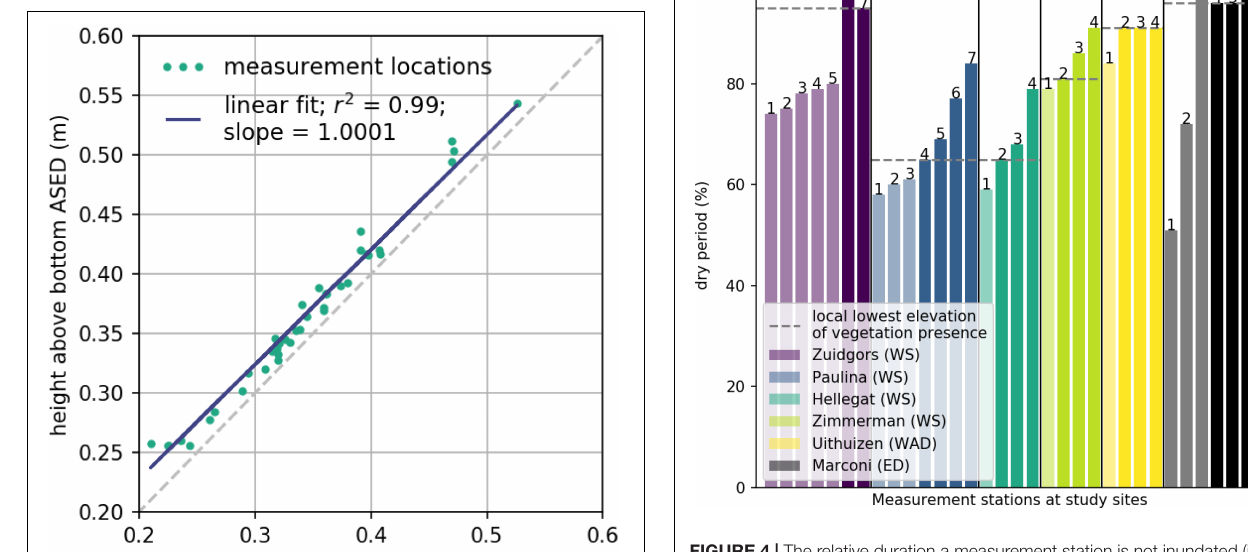
FIGURE 4 | The relative duration a measurement station is not inundated (i.e., dry period). The light colored bars indicate a location where vegetation is absent (bare tidal flat), whereas the dark colored bars indicate a location where vegetation is present (vegetated salt marsh). The dashed lines indicate the local lowest elevation where vegetation is present per study site. Numbers relate to the numbers of the measurement stations, introduced in Figure 1 . WS indicates Western Scheldt, WAD indicates Wadden Sea and ED indicates